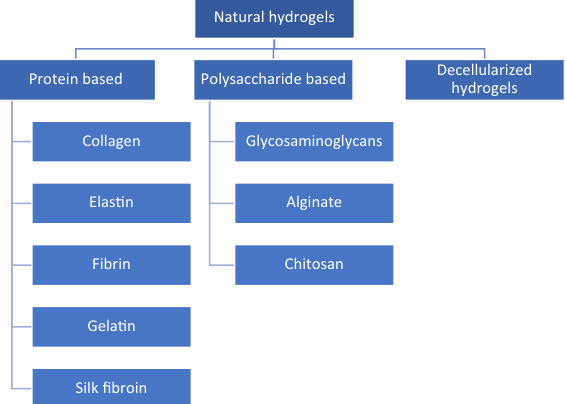
Table 1 Classi fi cation of gelation mechanism in natural hydrogels